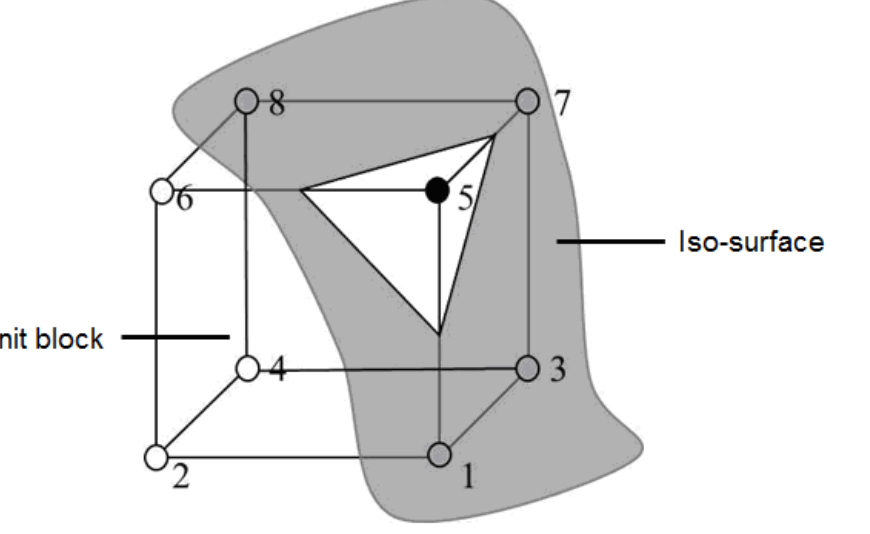
Figure 9. The 3D iso-surface intersects unit block.